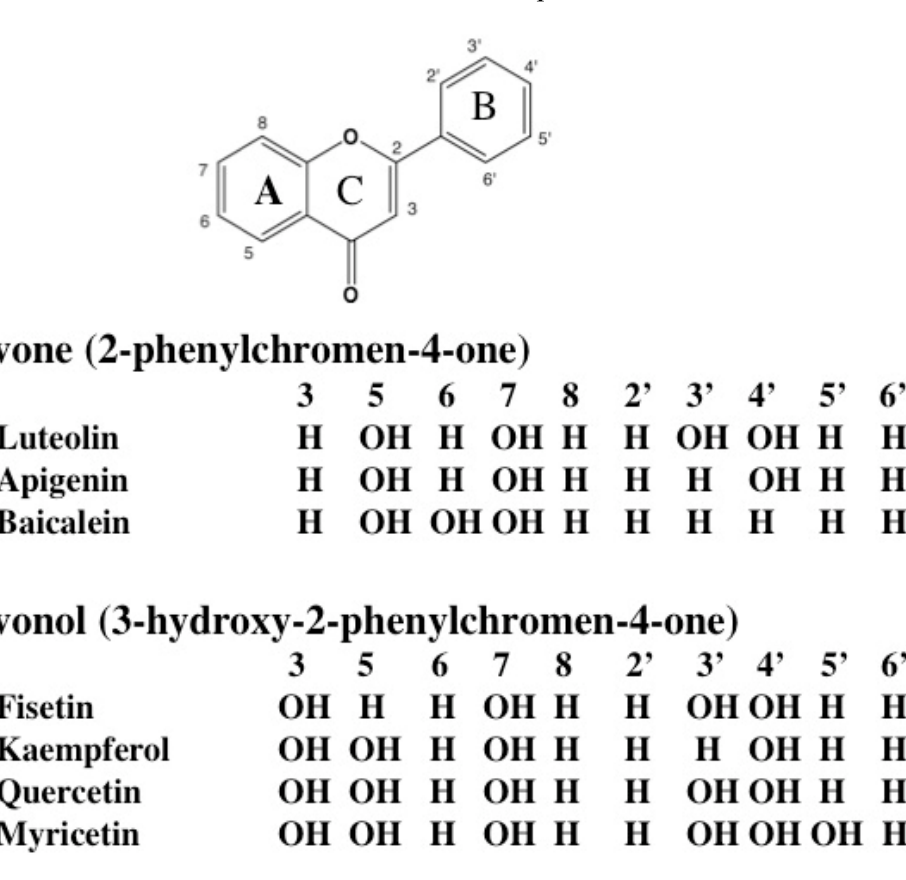
Figure 1. Structure of basic flavonoid skeletons and representative flavones and